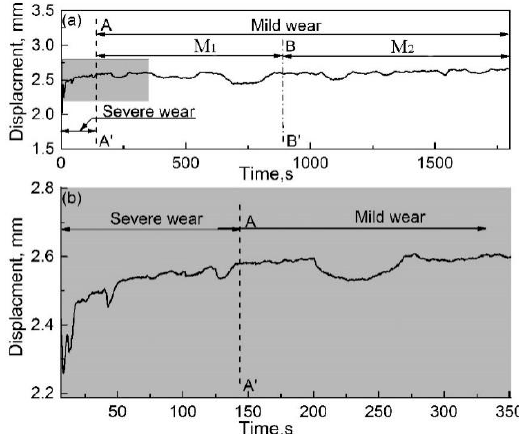
Figure 15. Pin-displacement evolution during friction when the RD was not used; H = 26.1 × 10 3 A/m. ( a ) Complete drawing and ( b ) local enlarged drawing of the shadowed region in (a).